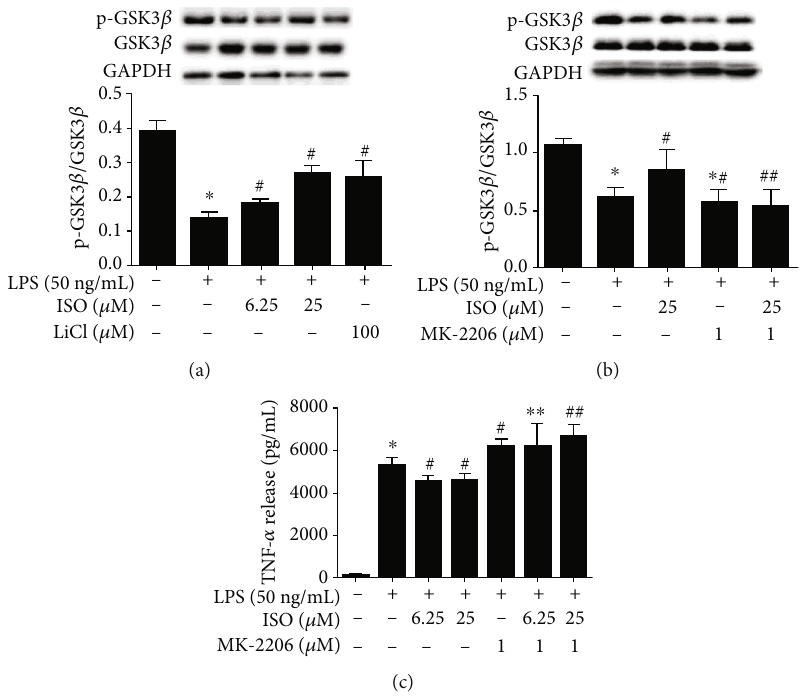
Figure 2: E ff ects of isoorientin on the phosphorylation of GSK3 β (Ser9) and TNF- α in LPS-induced RAW264.7 cells. (a) E ff ects of isoorientin and LiCl on p-GSK3 β and (b) e ff ects of MK-2206 on p-GSK3 β . RAW264.7 cells were treated with isoorientin (6.25 and 25 μ M) or LiCl (100 μ M) for 1h without (a) or with (b) prior treatment of MK-2206 (1 μ M) for 30 min and then stimulated with LPS (50 ng/mL). After 30min of LPS stimulation, the cells were collected for immunoblotting of p-GSK3 β , GSK3 β , and GAPDH ( n = 3 , 3 independent experiments). After 8 h of LPS stimulation, the cell supernatants were collected, and the levels of TNF- α were detected by ELISA ( n = 4 , 4 replicates) (c). The data were expressed as mean ± SEM . Statistical analysis was done using ANOVA. ∗ P < 0 : 05 versus the control group, # P < 0 : 05 versus the LPS group. ∗∗ P < 0 : 05 versus the isoorientin 6.25 μ M group, ## P < 0 : 05 versus the isoorientin 25 μ M